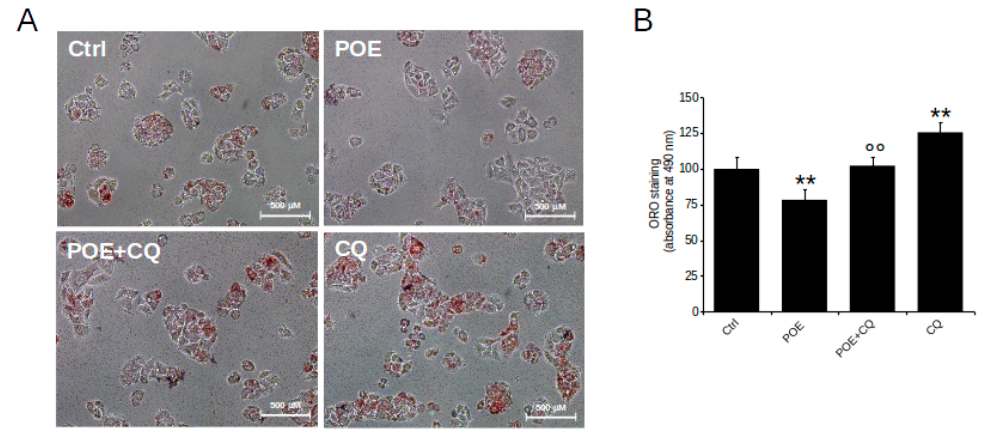
Figure 5. POE reduces lipid accumulation in HepG2 cells through autophagy activation. ( A ) Representative image of ORO-stained HepG2 cells treated with POE (7.2 µ g/mL), CQ (10 µ M), or POE added with CQ at 7 h (POE + CQ) until 24 h. ( B ) Changes in intracellular lipid content assessed by measuring ORO absorbance at 490 nm. Data were reported as the mean ± SD of at least three independent experiments. ** p < 0.01 vs. untreated control cells (Ctrl); °° p < 0.01 vs. POE ‐ treated cells. Tukey’s HSD test.